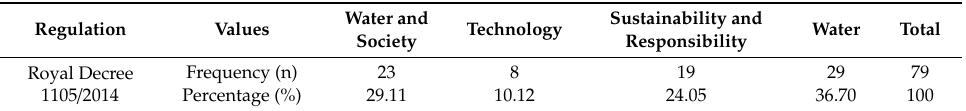
Table 1. Frequency (n) and percentage (%) of references to water in the secondary education curriculum (Royal Decree 1105 / 2014) by category.